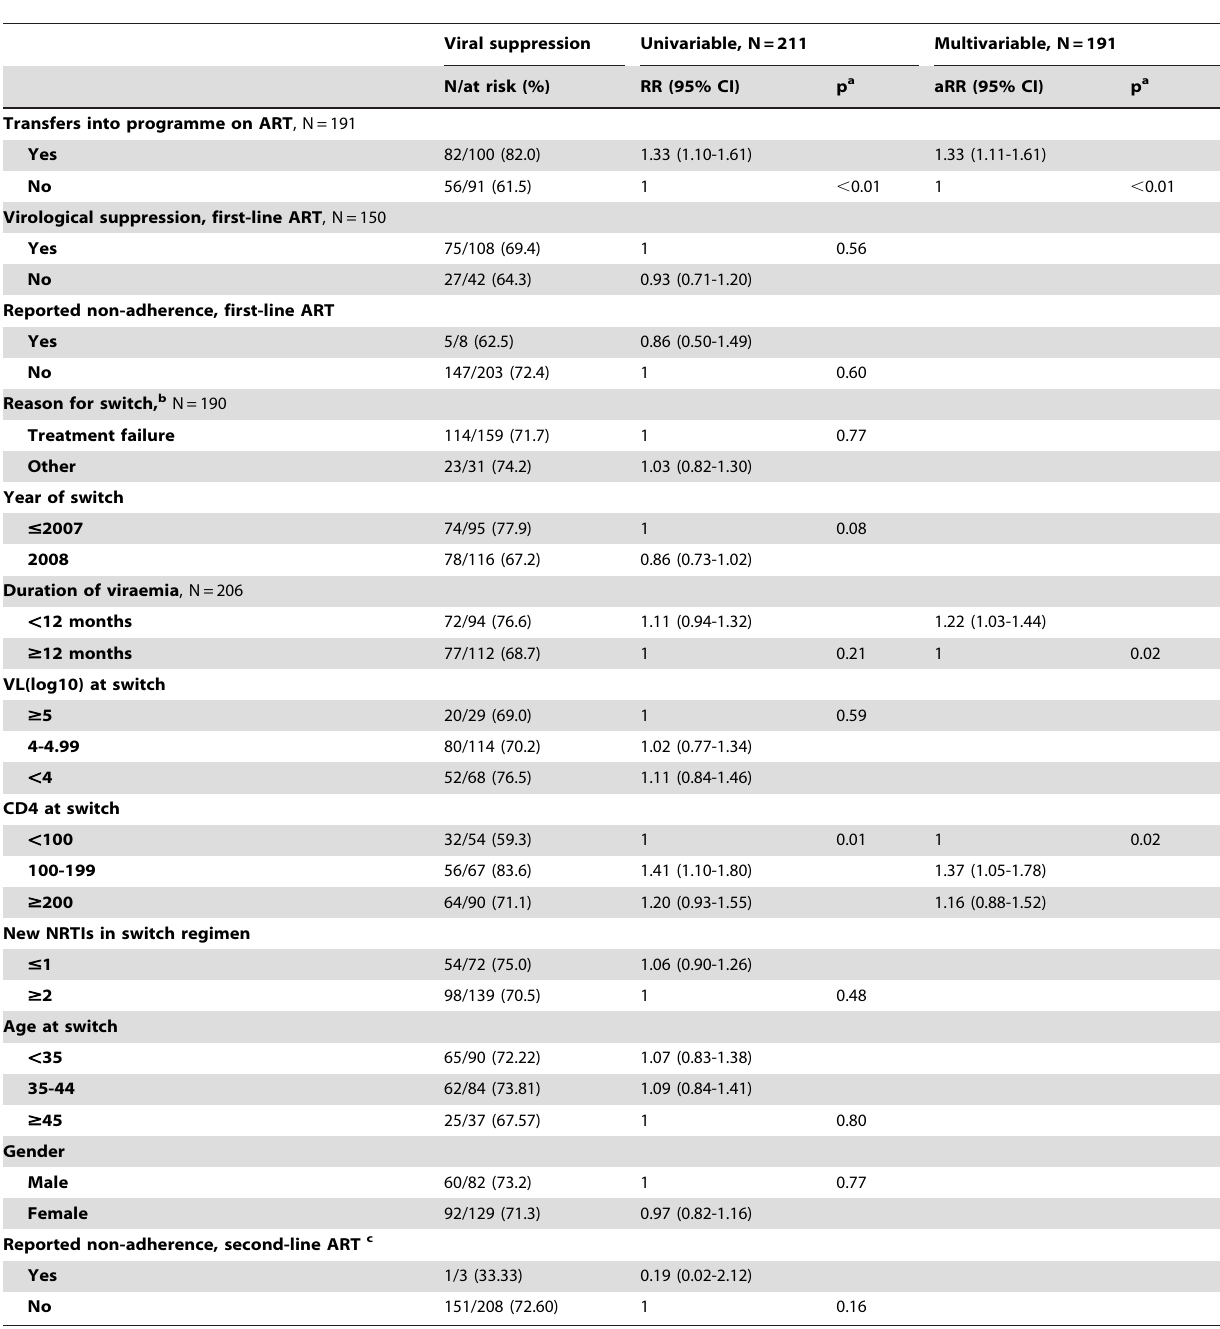
Table 4. Predictors of early viral suppression (viral load , 400 copies/ml) on second-line ART in the community